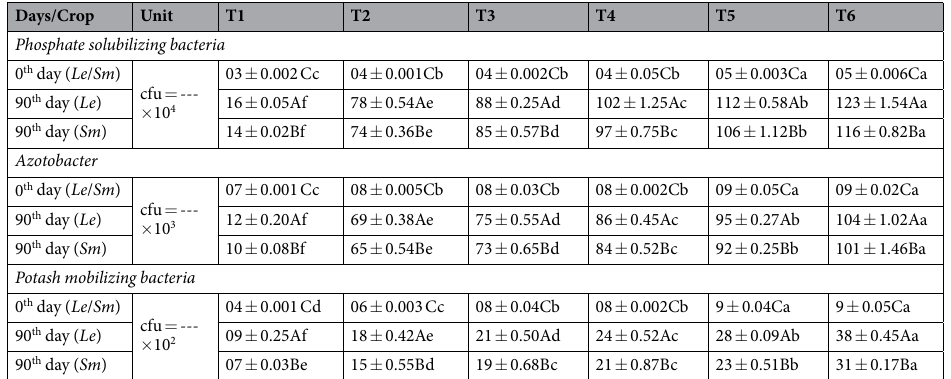
Table 3. Bacterial Population in soil amended with vermicomposted fly ash before (0 th day) and after (120 th day) harvesting of Lycopersicon esculentum and Solanum melongena . Le: Lycopersicon esculentum ; Sm: Solanum melongena ; cfu: colony forming unit. Values are in Mean ± SD; (n = 3). Different small letters along the row represents significant differences in the bacterial count of different treatments of Le and Sm at a particular time interval (sowing and harvesting) according to Duncan’s Multiple Range Test (One-way ANOVA) at p < 0.05 . Different capital letters along the column represents significant differences in the count of phosphate solubilizing bacteria, Azotobacter and Potash mobilizing bacteria in soil of Le and Sm before and after plantation within the same treatment, respectively, according to Duncan’s Multiple Range Test (ANOVA) at p < 0.05 .